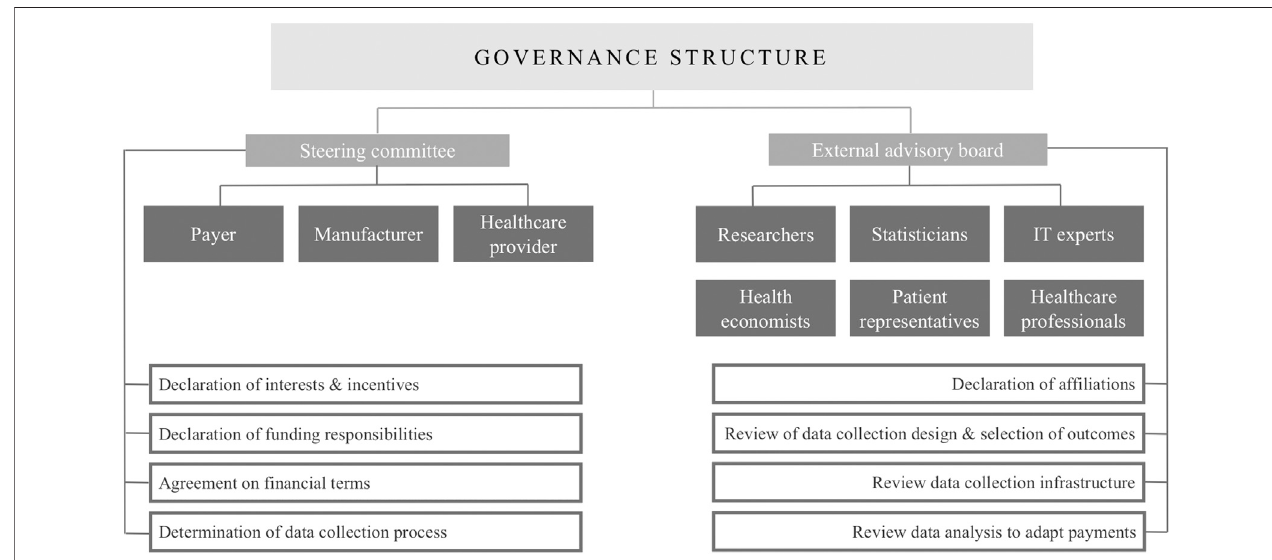
FIGURE 2 | Proposed governance structure for the implementation of outcome-based spread payments.